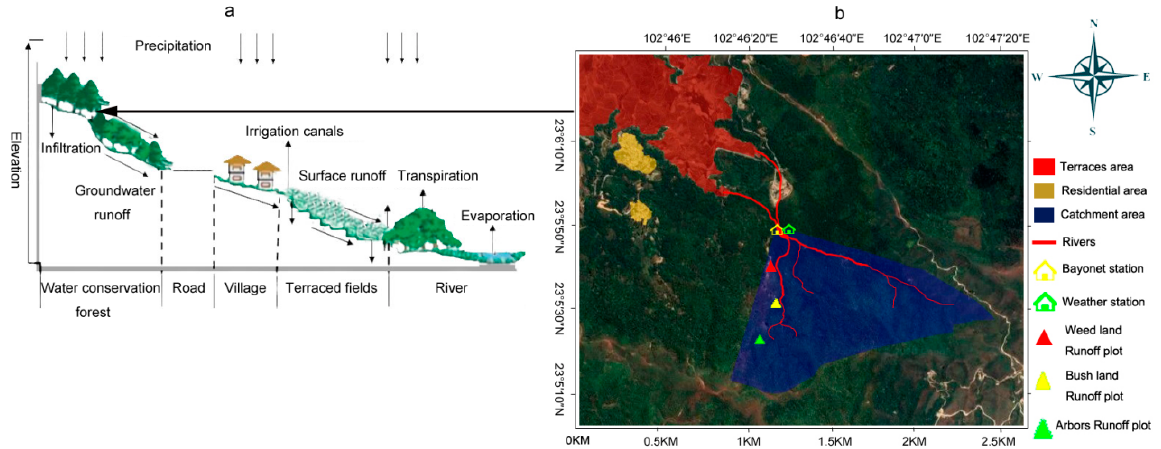
Figure 1. ( a ) An ecosystem structure map of the Hani Rice Terraces with Four prime isomorphisms “Forest-Village-Terrace-River”; ( b ) Location of the study area in Honghe Hani Rice Terraces. The study area is located in the forest of Quanfuzhuang Watershed (Figure 1b), with an area of 0.78 km 2 , which belongs to Honghe Hani and Yi Autonomous Prefecture in South Yunnan (23 ◦ 5 (cid:48) 10” N–23 ◦ 5 (cid:48) 50” N and 102 ◦ 46 (cid:48) 20” E–102 ◦ 47 (cid:48) 20” E), China. The